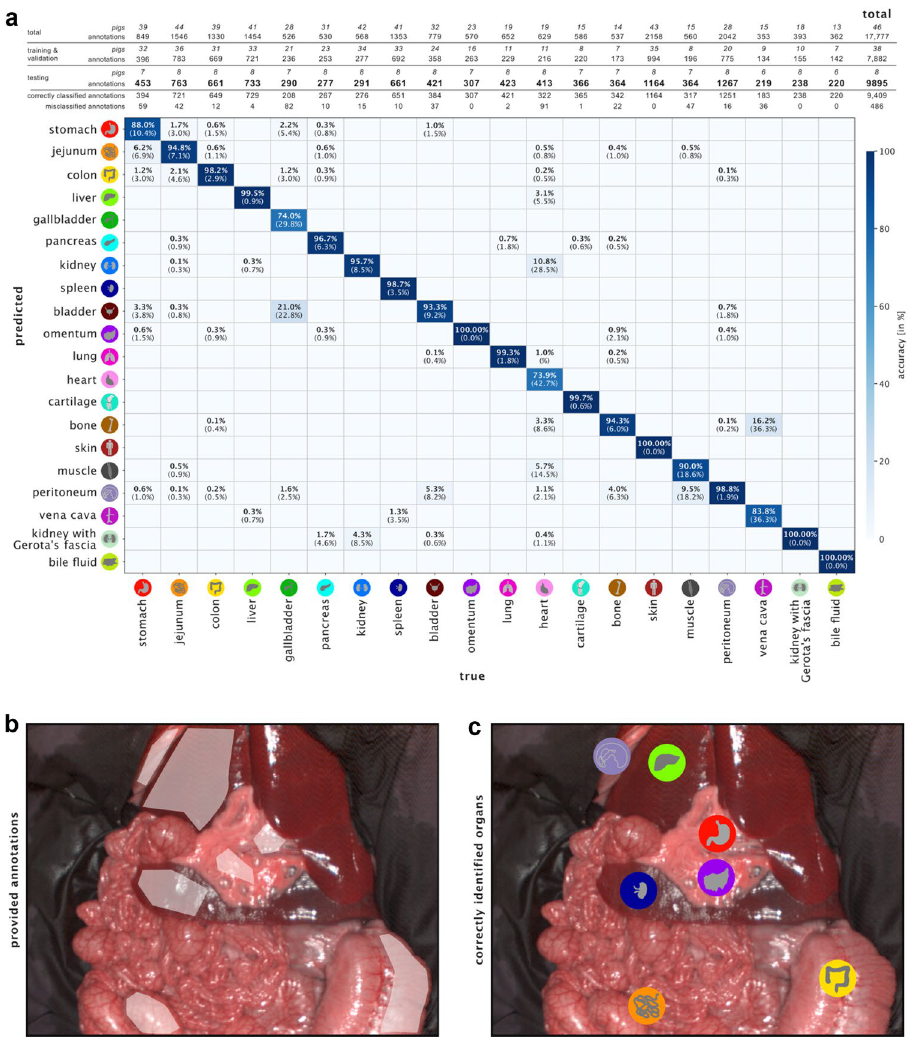
Figure 5. Results of deep learning-based organ classification. ( a ) confusion matrix which was generated for a hold-out test set comprising 9895 annotations from 5293 images of 8 pigs that were not part of the training data. Confusion matrices were calculated and column-wise normalized (i.e. divided by the column sum) per pig based on the absolute number of (mis-)classified annotations. These normalized confusion matrices were averaged across pigs while ignoring non-existent entries (e.g. due to missing organs for one pig). Each value in the matrix thus depicts the average fraction of annotations which were labeled as the column class and predicted as the row class. Numbers in brackets depict the standard deviation across pigs. Zero values are not shown in the confusion matrix in order to improve visibility. Since multiple organs can appear on the same image, the number of annotations exceeds the number of images. ( b ) Exemplary image with multiple organ annotations by an expert. ( c ) Organs classified through deep